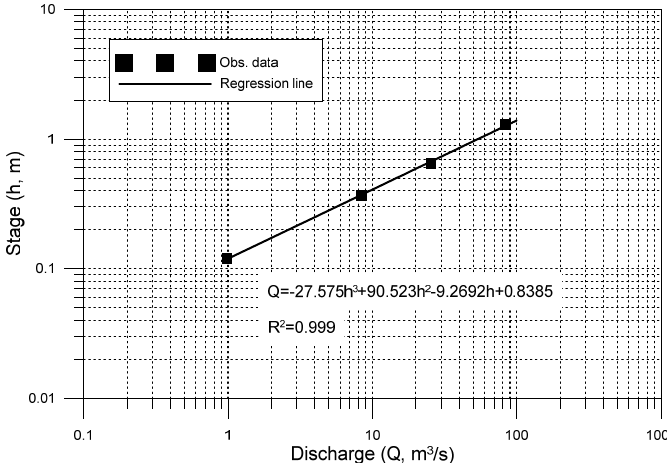
Figure 6. Stage-discharge rating curve of the watershed case study.